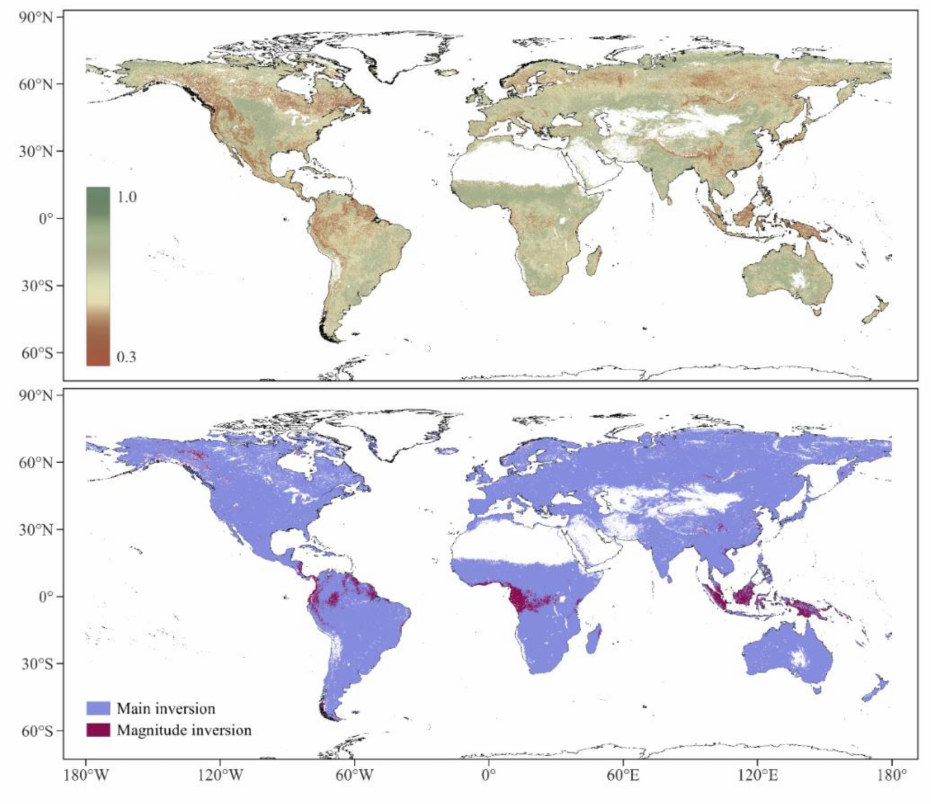
Figure 3. The global product composited from the daily product collection in 2020. The top panel shows the global CI distribution, and the quality indicator is discretely colored in the bottom